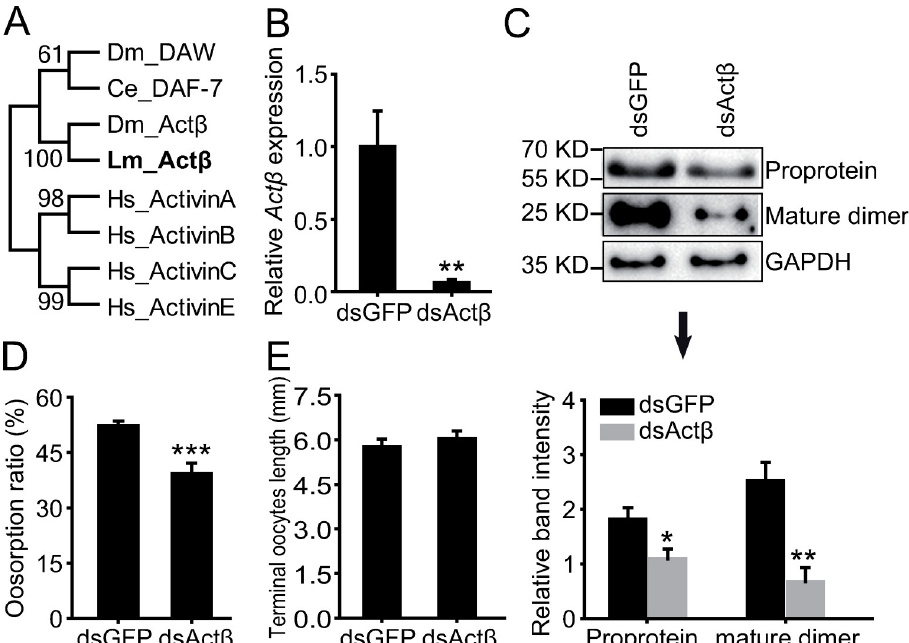
Fig 3. Effects of Act β knockdown on oosorption. (A) Neighbor joining tree construction of TGF β ligand subfamily in four species. Consensus unrooted trees were generated with 1000 bootstrap trials using the neighbor-joining method. Lm, Locusta migratoria ; Ce, Caenorhabditis elegans ; Dm, Drosophila melanogaster ; Hs, Homo sapiens . (B) Gene expression level of Act β in the terminal oocytes after dsGFP or dsAct β injection. n = 9–10. (C) Protein expression level of Act β in the terminal oocytes after dsGFP or dsAct β injection. n = 4. (D) Oosorption ratio after dsGFP or dsAct β injection. n = 18. (E) Length of terminal oocytes after dsGFP or dsAct β injection. n = 8–9. � P < 0.05, �� P < 0.01, ��� P <